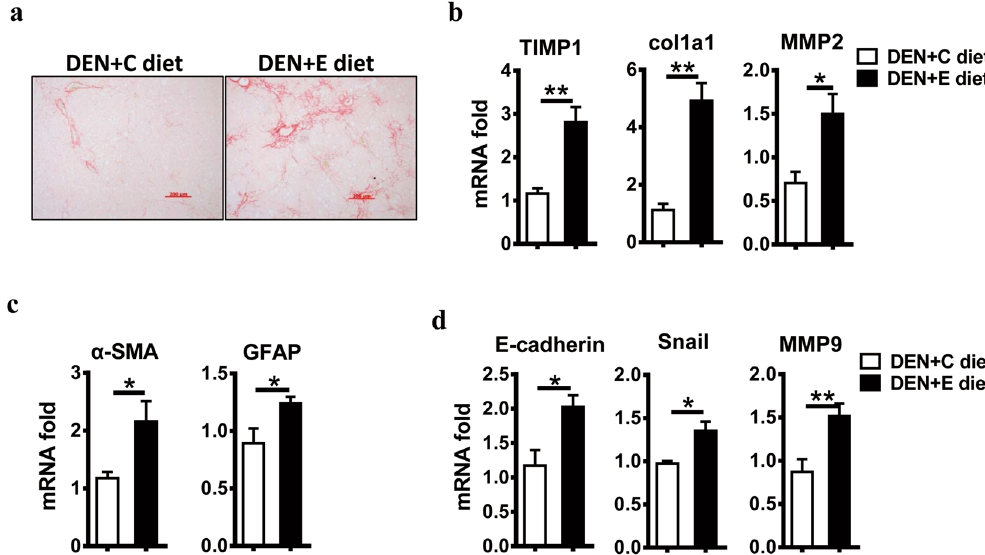
Figure 5. Alcohol consumption promotes liver fibrosis and epithelial-mesenchymal transition in DEN- initiated tumorigenesis. ( a ) Sirius red staining of sections (original magnification, 200 × . Scale bar, 200 μ m) were performed in DEN + C diet and DEN + E diet treated-livers. ( b ) Fibrosis marker gene expression levels in DEN + C diet and DEN + E diet were analyzed by Q-PCR. Data are shown as the means ± SEM (n = 4 for DEN + C diet, n = 6 for DEN + E diet). * P < 0.05. ** P < 0.01. ( c ) HSC activation marker gene expression levels in DEN + C diet and DEN + E diet were determined by Q-PCR. Data are shown as the means ± SEM (n = 4 for DEN + C diet, n = 4–5 for DEN + E diet). * P < 0.05. ( d ) Hepatic mRNA levels of E-cadherin, Snail, MMP9 in DEN + C diet and DEN + E diet mice were analyzed via Q-PCR. Data are shown as the means ± SEM (n = 4 for DEN + C diet, n = 6 for DEN + E diet). * P < 0.05. ** P < 0.01.